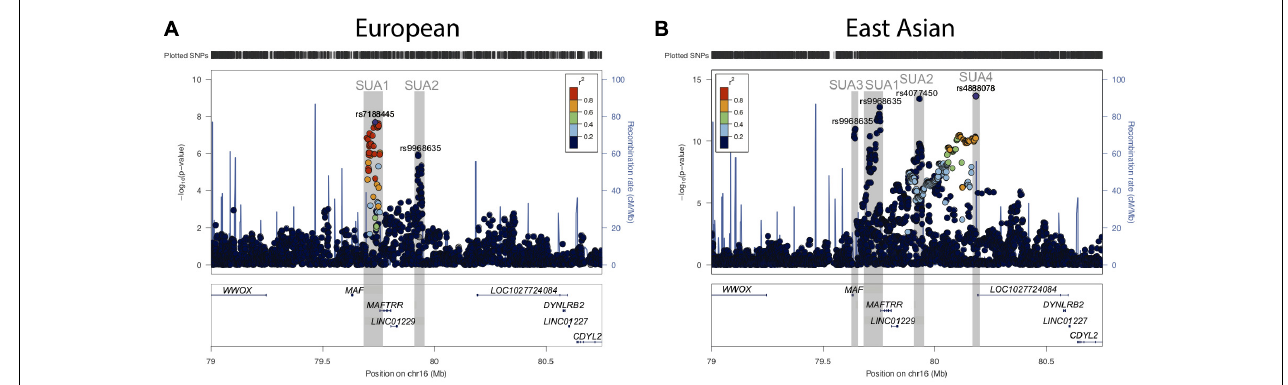
FIGURE 1 | Serum urate associated regions upstream of the MAF gene. (A) Regional association plots for serum urate associated SNPs upstream of the MAF TSS and in proximity to the lincRNA region encompassing MAFTRR , LINC01229 , and LOC1027724084 from (A) Köttgen et al. (2013) and (B) Kanai et al. (2018). Surrounding genes include WWOX , DYNLRB2 and CDYL2 . Dots indicate individual SNPs while their position relative to the left Y -axis indicates the significance ( − log 10 P ) of association with serum urate levels. The blue line indicates the recombination rate across the locus. The SUA1, SUA2, SUA3, and SUA4 regions upstream of MAF are indicated by gray boxes and were defined by SNPs with p < 10 - 6 and LD with the lead SNP at the SUA region R 2 > 0.8. The lead SNPs (A) rs7188445 (SUA1) in Europeans and (B) rs4888078 (SUA4) in East Asians are indicated by a purple dot. The color of the surrounding SNPs indicates the strength of LD with the lead SNP according to the key in the left top hand corner, measured as r 2 found in the HapMap data (hg19/1000 genomes Nov 2014) for Europeans (A) and East Asian (B) . The lead SNP of each SUA region is indicated above the signal in Europeans (A) and East Asians (B) . The plot was generated using LocusZoom (Pruim et al., 2010).